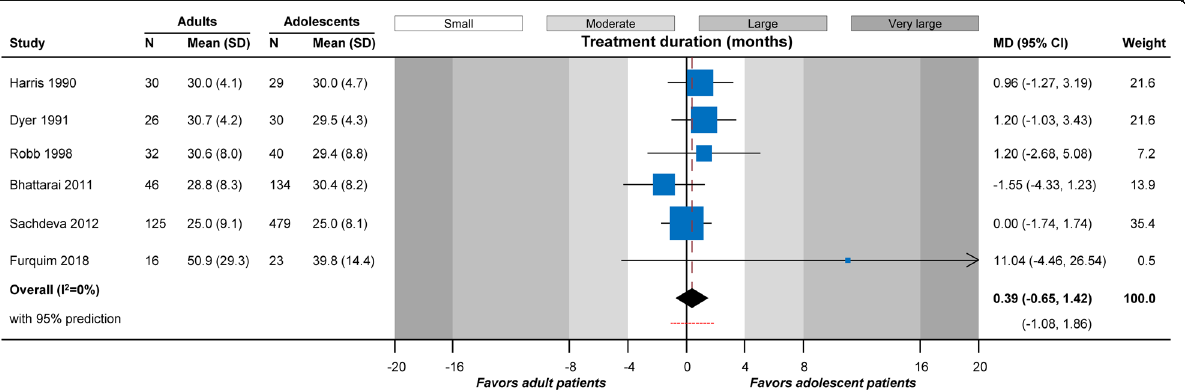
Fig. 2 Contour-enhanced forest plot for the duration of comprehensive treatment among adolescents and adult patients. N, number of patients; SD, standard deviation; MD, mean difference; CI, confidence